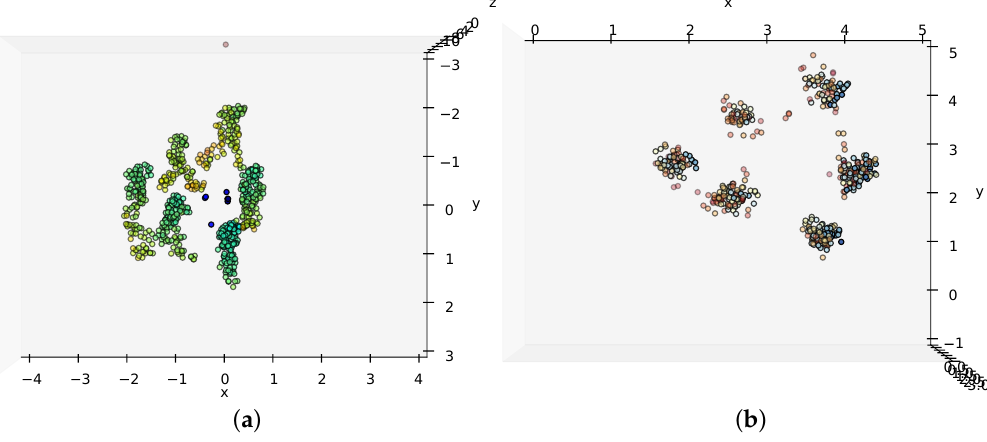
Figure 2. Example showing the reconstructed 3D points of the example shown in Figure 1. The points are colored according to their z -coordinate. ( a ) 3D points in the left camera frame; ( b ) top-down view of the 3D points in the street